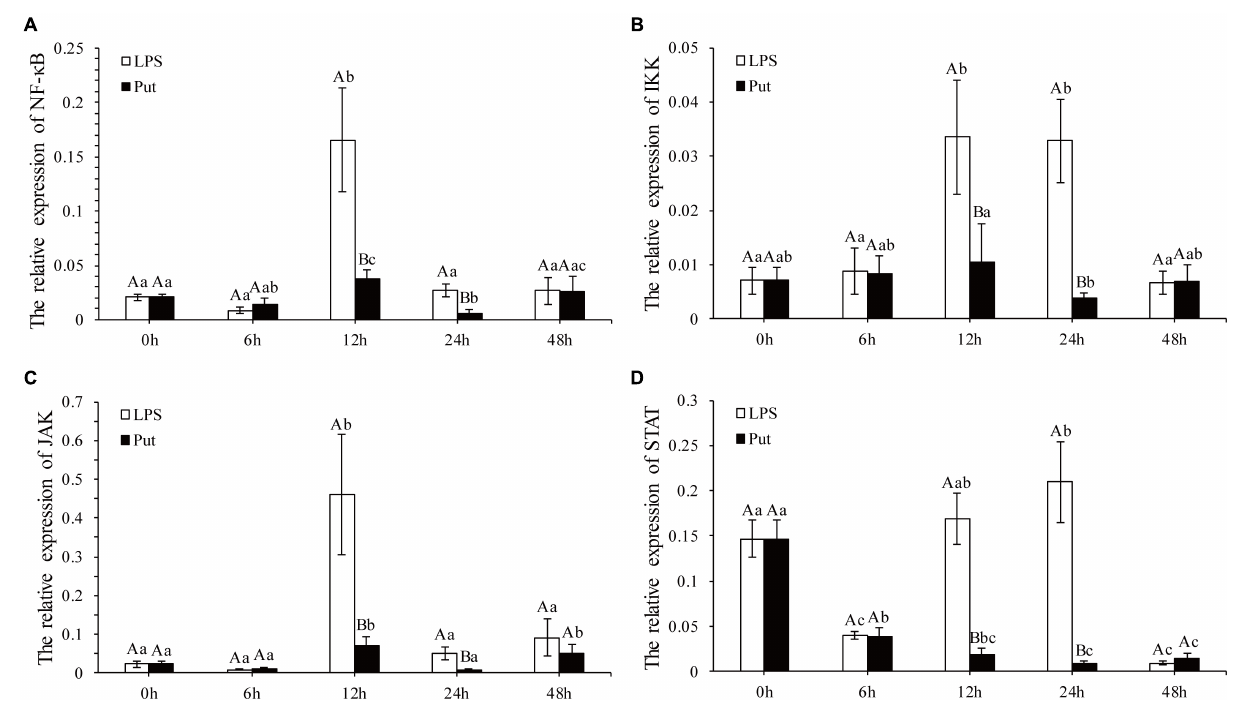
FIGURE 5 | Expression of the nuclear factor kappa B (NF- κ B), I κ B kinase (IKK), Janus kinase (JAK), and signal transducer and activator of transcription proteins (STAT) genes after putrescine treatment. Values are shown as mean ± SE ( N = 5). Lipopolysaccharide (LPS) group, PBS_LPS; Put group, Put dihydrochloride_LPS. Lowercase letters represent differences at different time points in the same groups, and capital letters represent differences in the different groups at same time points. (A–D) represent the expression of NF- κ B/IKK/JAK/STAT after the putrescine treatment,